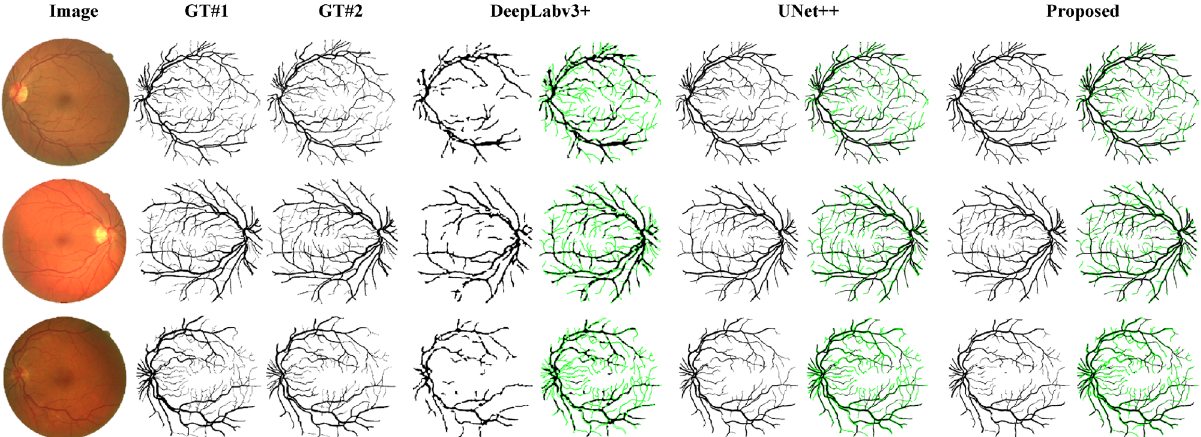
Figure 6. Examples of the segmented retinal blood vessels. The first column to the last column refers to original retinal images, first ground-truth (GT#1), second ground-truth (GT#2), and the segmentation results via DeepLabv3 + , UNet + + , and proposed CMM-Net. The segmented results with the missing retinal vessels are drawn in green contours for all